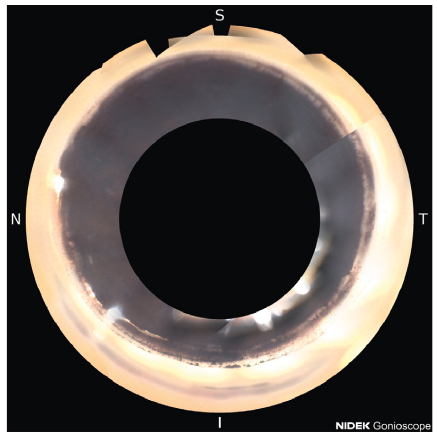
Figure 2: Distal extrusion of the Hydrus stent from Schlemm’s